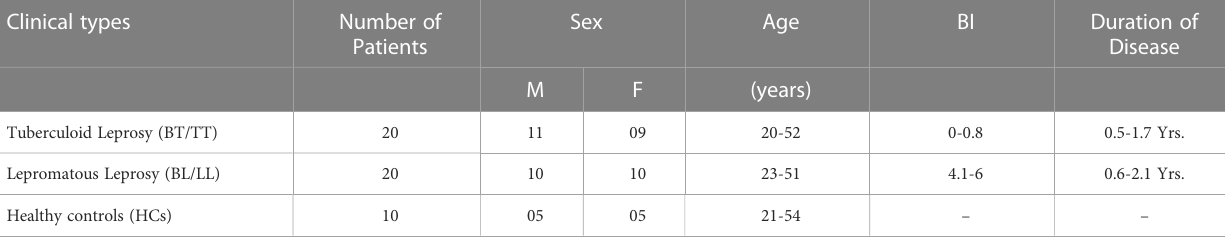
TABLE 1 Clinical details of 40 newly diagnosed untreated leprosy patients and 10 healthy control subjects. Clinical